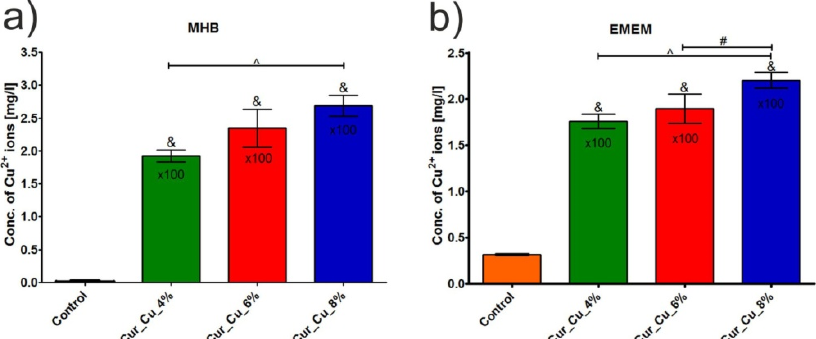
Figure 4. Concentration of copper ions in extracts obtained from Cur_Cu_4%, Cur_Cu_6%, and